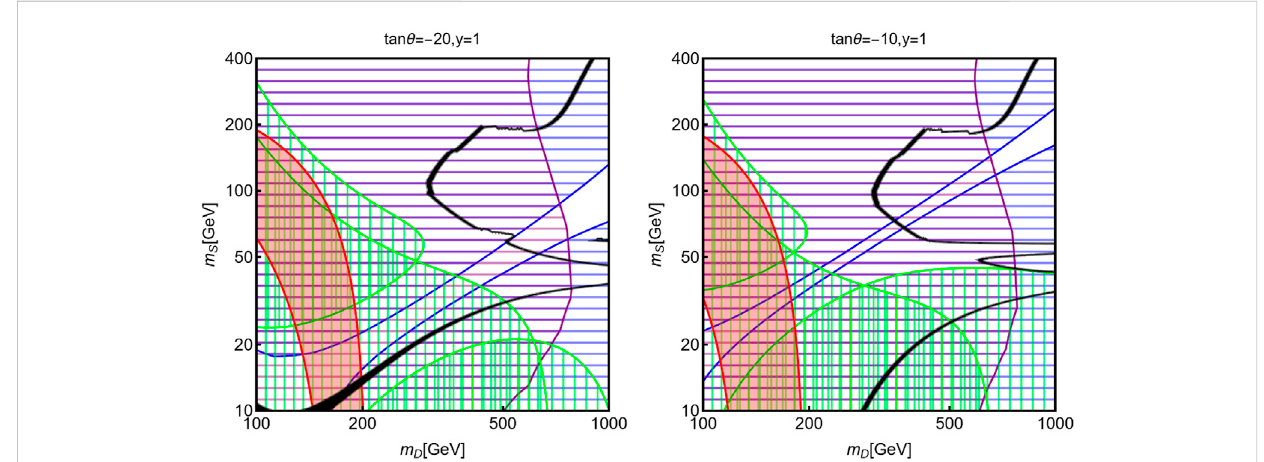
FIGURE 2 Summaryofconstraintsforthesinglet – doubletmodel:theblackisocontourcorrespondstothecorrectrelicdensity,whiletheredregionsprovidea